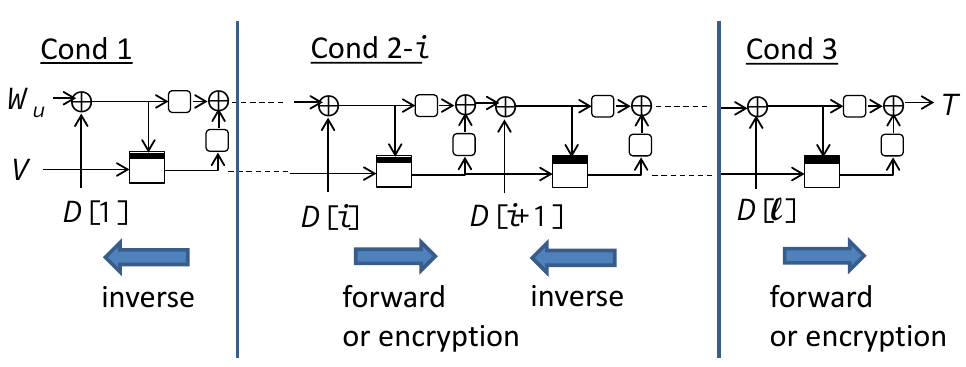
Figure 4: Conditions of Multi-Collision